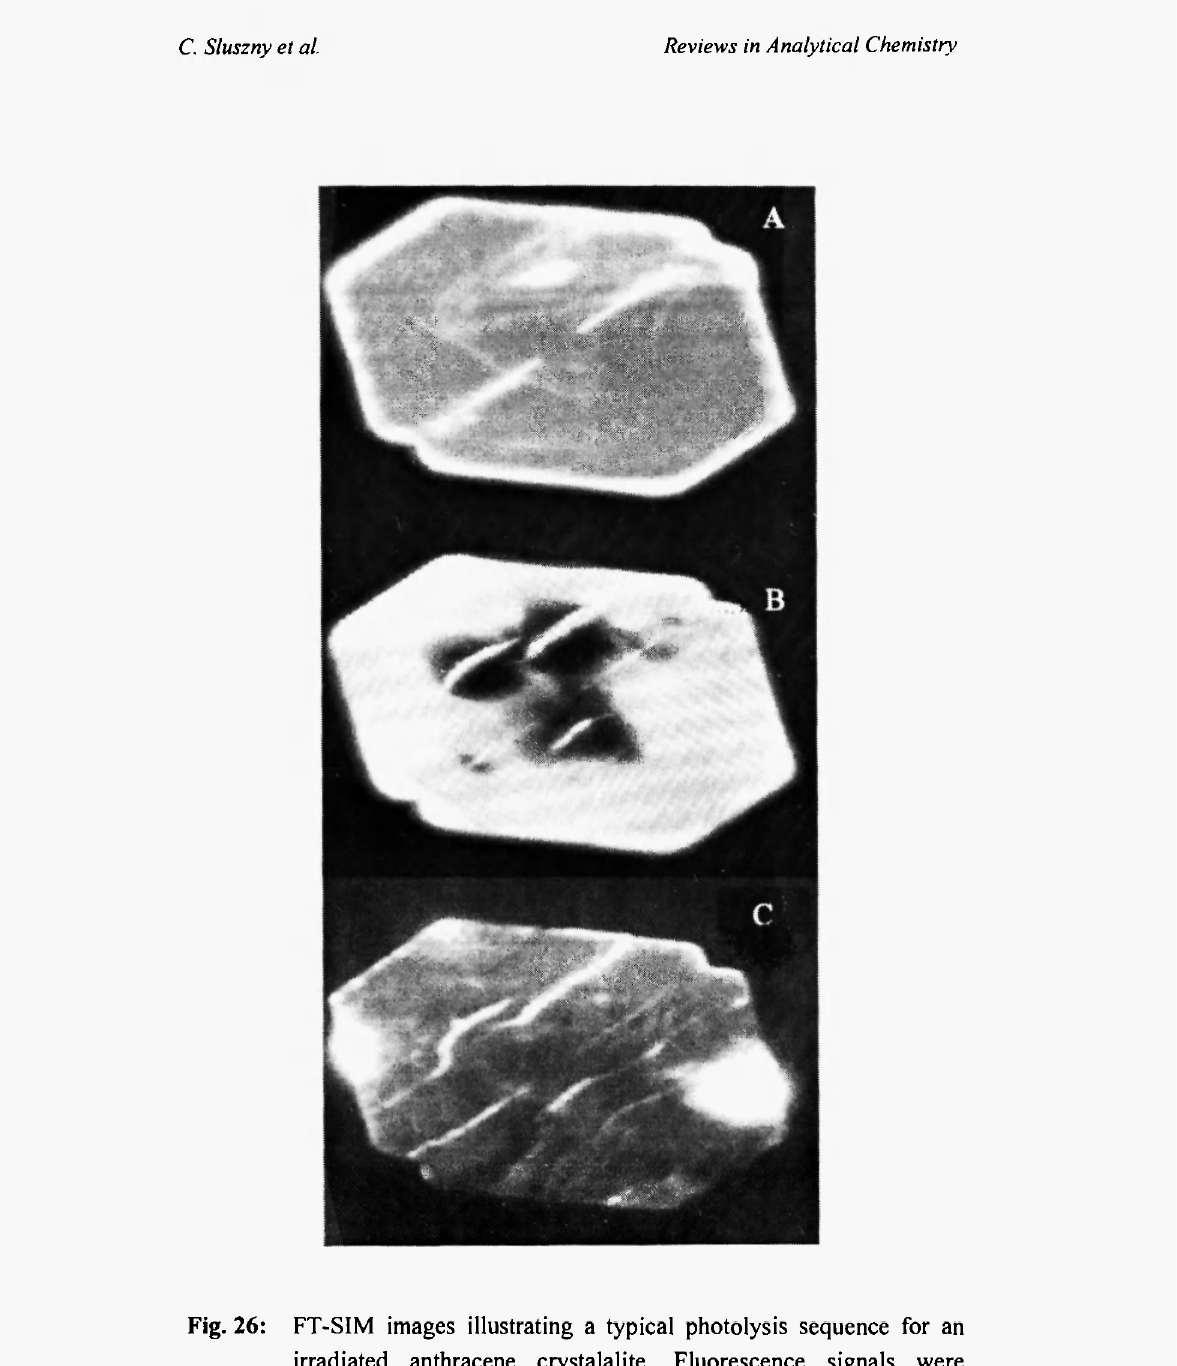
Fig. 26: FT-SIM images illustrating a typical photolysis sequence for an irradiated anthracene crystalalite. Fluorescence signals were obtained: a) after a 1 min. irradiation, b) after 15 min. irradiation, and c) after 60 min. light irradiation.